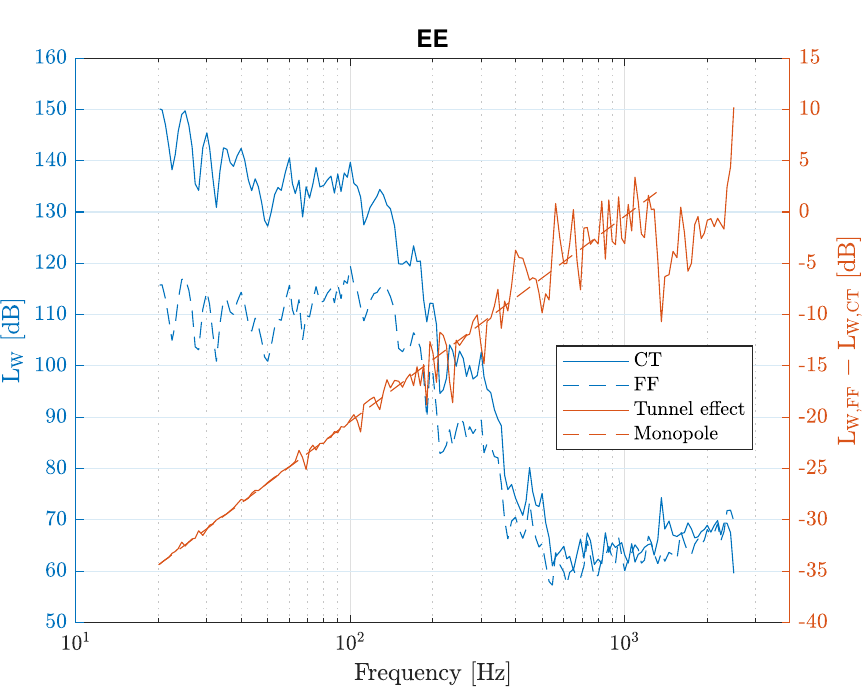
Figure 32. Sound power levels and correction terms for the cavitator test case (EE solution) in cavitation tunnel (CT) and in free field (FF).